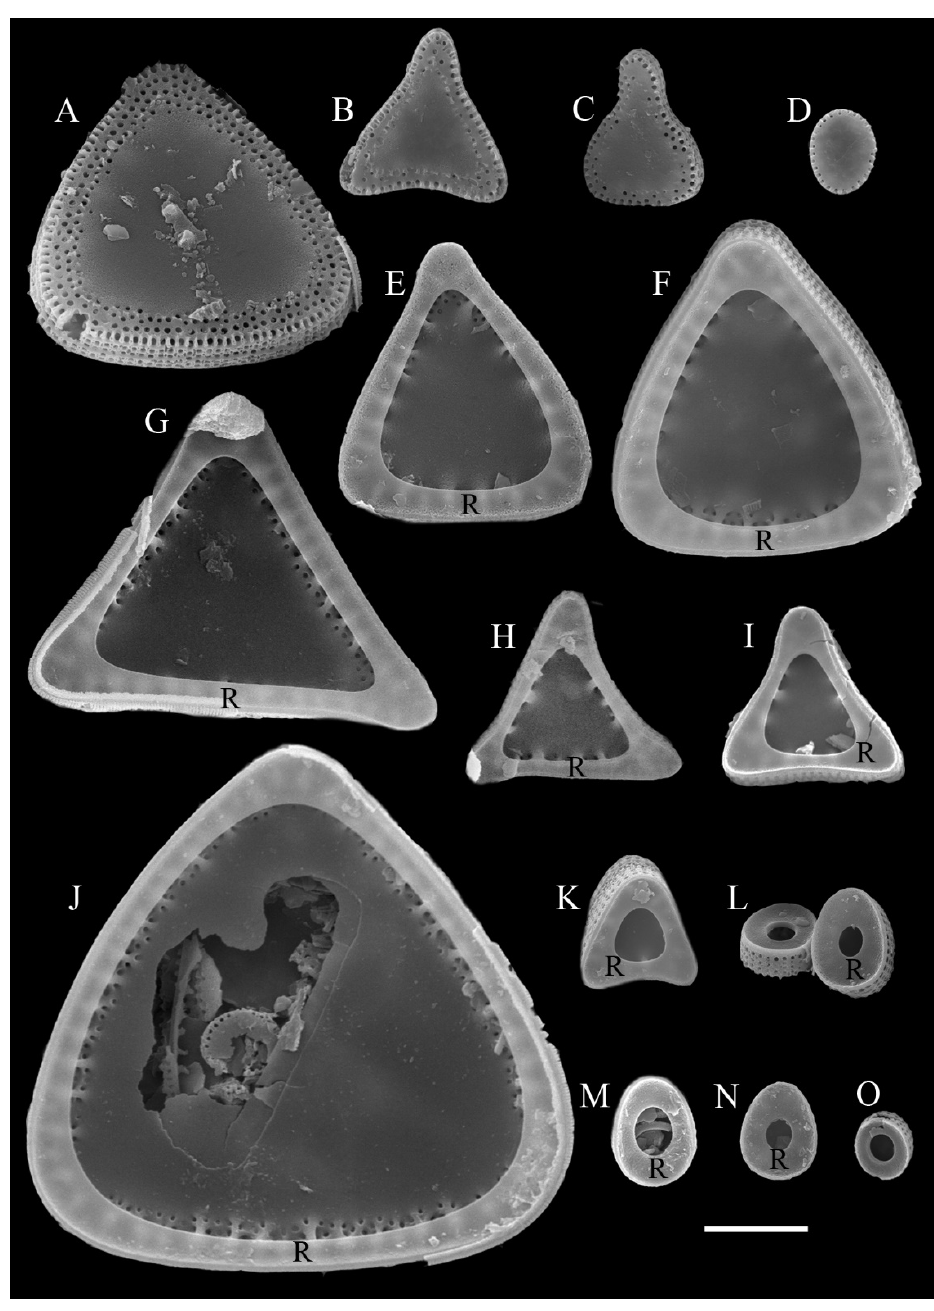
Figure 11. Alveolophora antiqua in the depth interval of 48–44.5 m from core 517 of the Barguzin Valley: A – D —external views, valve face; E – O —internal views showing a ringleist (R), variability of valves and aperture of ringleist in their shape. SEM. Scale bar: 10 µm.